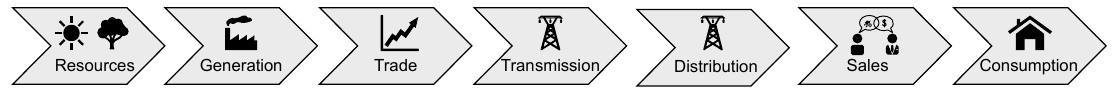
Figure 1. The classical value chain of the energy industry.